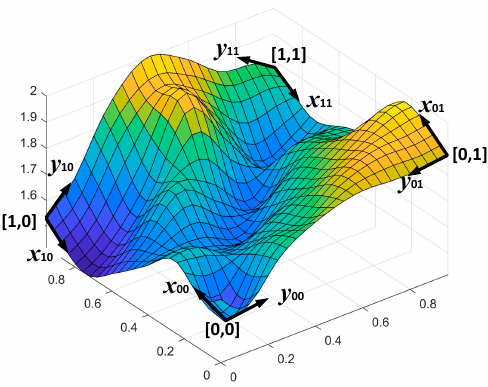
Figure 3. At integer grid points, 2D Perlin noise interpolates and smooths between pseudorandom gradients. Table 1. The algorithm of implemented 2D Perlin noise.